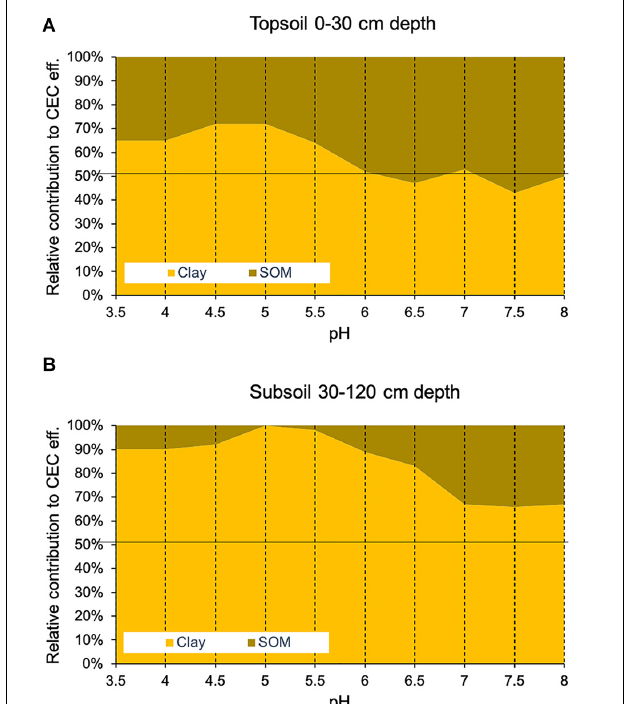
FIGURE 3 | Relative contribution of soil organic matter (SOM) and the percentage of clay to the effective cation exchange capacity across pH classes of (A) Swiss forest topsoils (0–30 cm depth) and (B) subsoils (30–120 cm depth). The contribution of SOM and clay was estimated using partial regression coefficient values as well as the content of SOM, clay and CEC